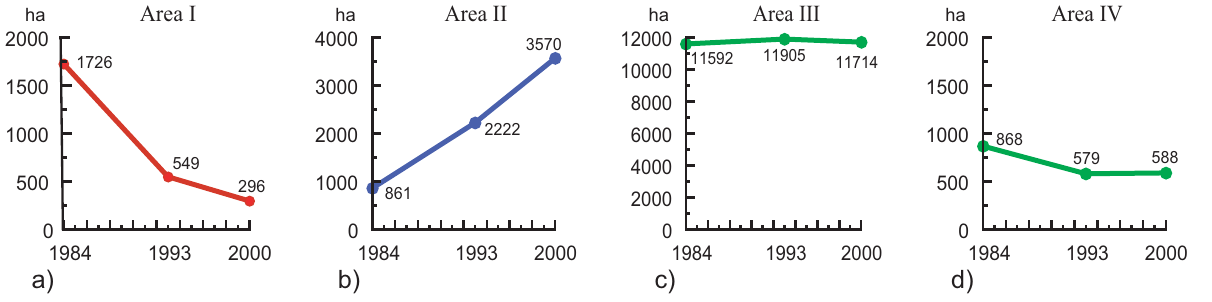
Figure 6. Changes in forest cover (ha) in the four surveyed areas (Area I–IV) based on analyses of Landsat images from 1984, 1993 and 2000.